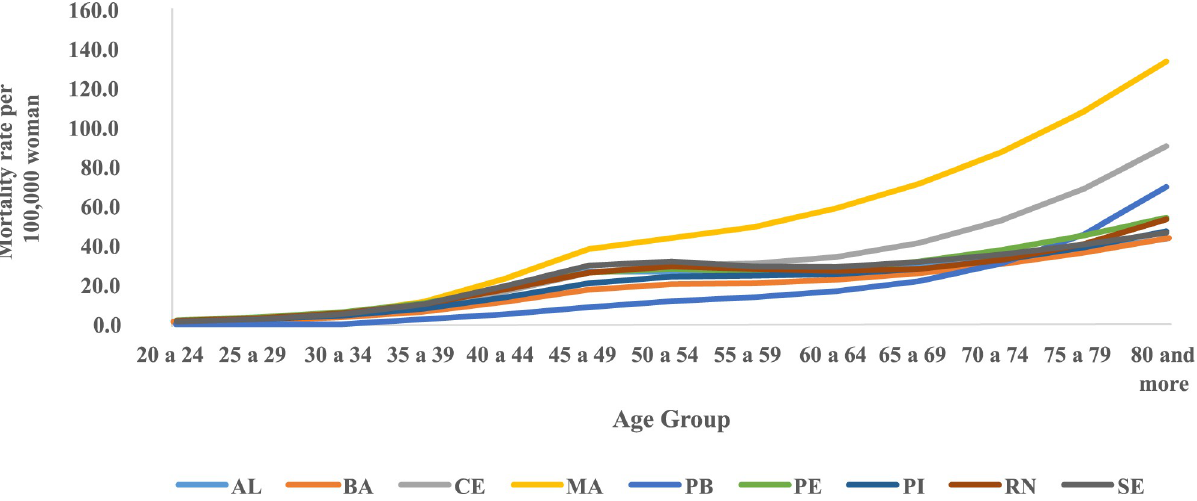
Fig 6. Results of the age-period-cohort model adjusted for cervical cancer mortality according to the age effect and states of the Northeast, Brazil,